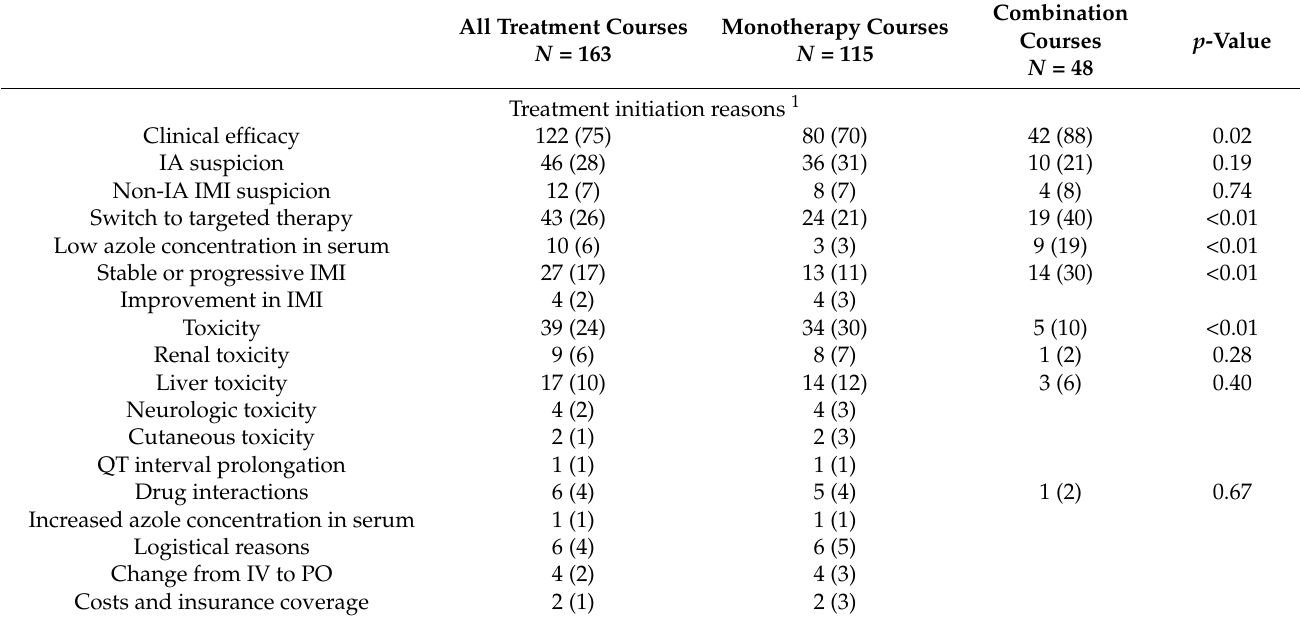
Table 4. Reasons for monotherapy and combination course